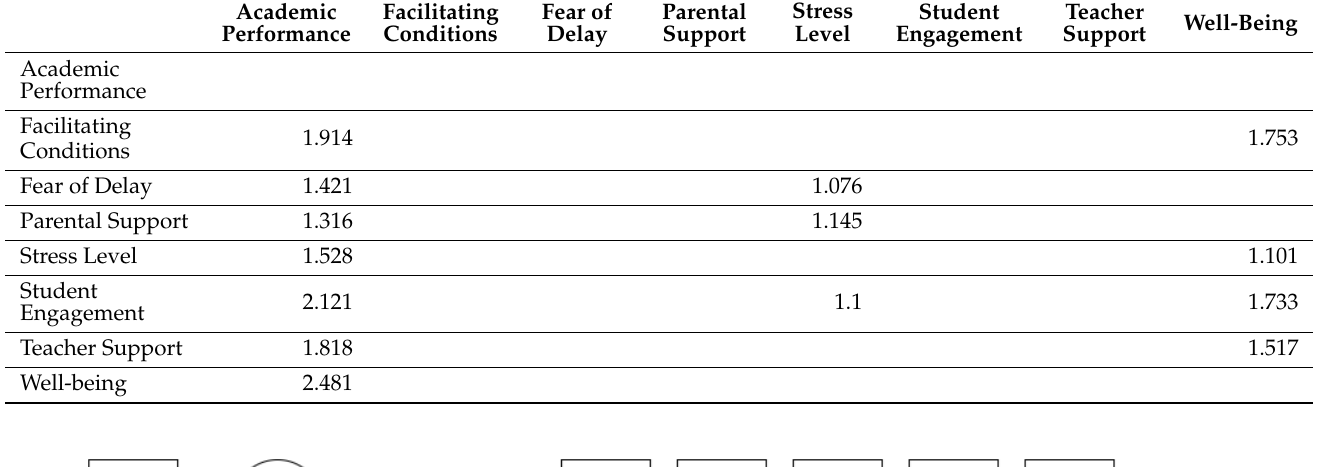
Table 6. Variance inflation factor value for all constructs.